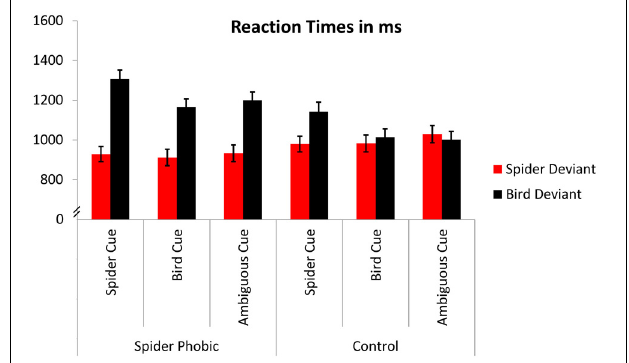
FIGURE 2 | Reaction times. Error bars depict standard